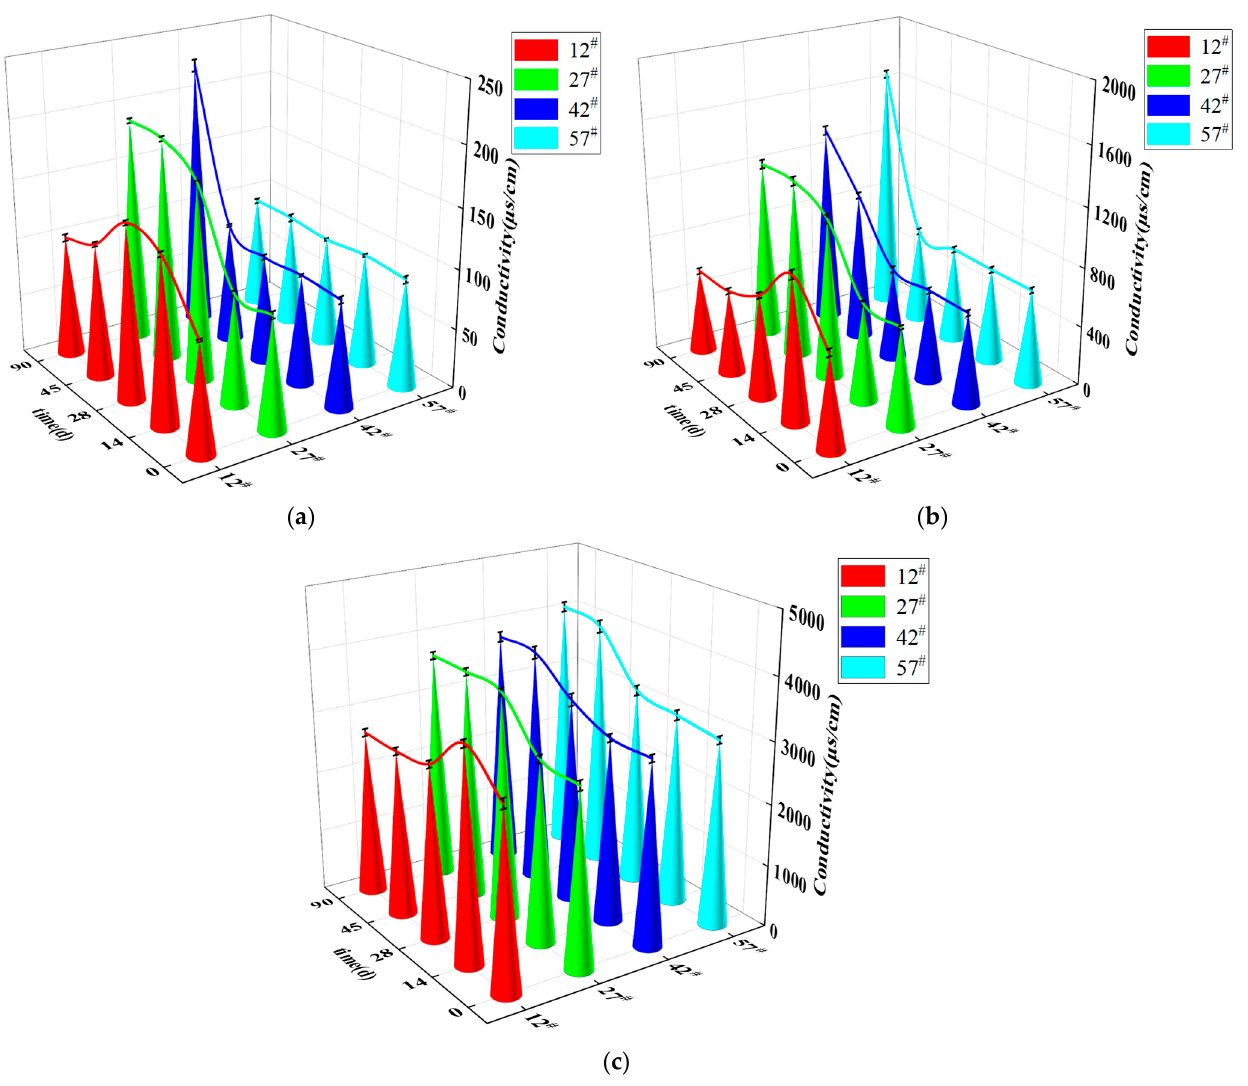
Figure 7. Variation of soil column conductivity with time for different NaCl contents: ( a ) 0%, ( b ) 0.3%, ( c ) 1.0%